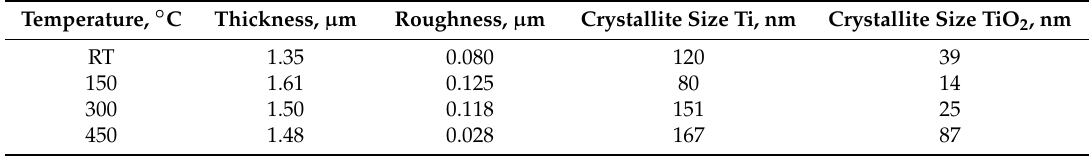
Table 1. Thickness and roughness from profilometry of Ti films; crystallite size of the deposited Ti films and anodized TiO 2 nanotubes. RT: room temperature.